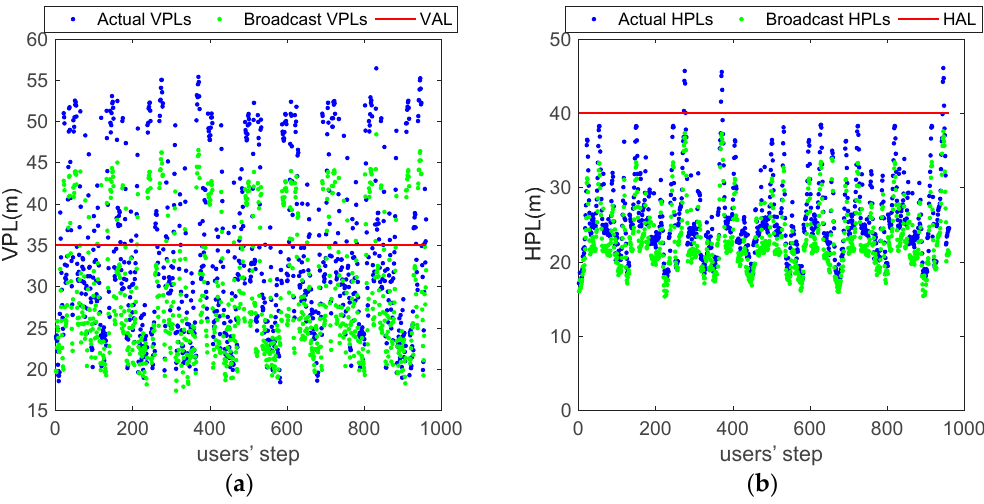
Figure 13. PLs for the computed σ URE / σ URA and the broadcast σ URE / σ URA . ( a )VPLs; ( b ) HPLs.